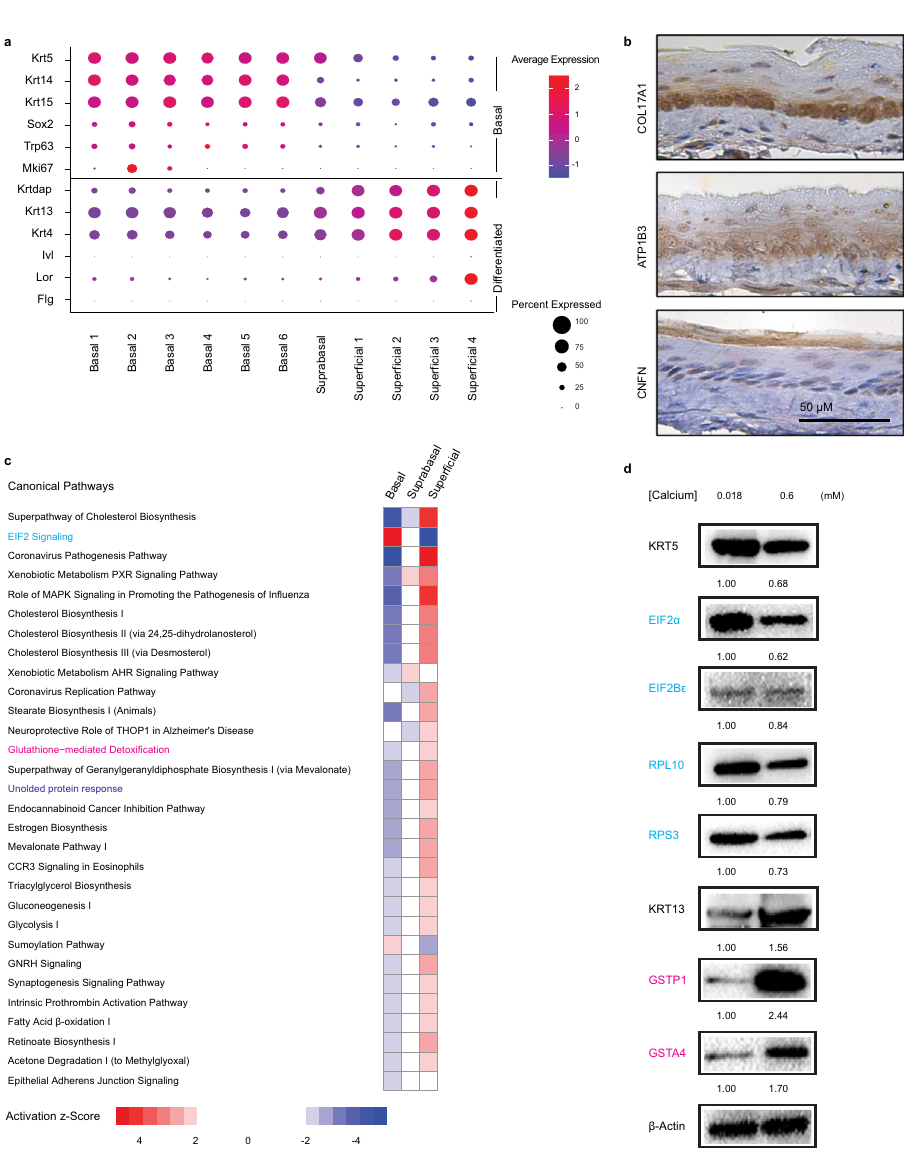
Fig. 1 Identi fi cation of cell populations in murine esophageal epithelium. a Schematic overview of experimental design. b Expression z-scores for the top 5 upregulated genes in each cluster. Red indicates enrichment while blue indicates inhibition. c Seurat ’ s Uniform Manifold Approximation and Projection (UMAP) was used to identify distinct cell populations within the epithelial dataset. Eleven epithelial cell populations were identi fi ed. d Genes identi fi ed as primary contributors to UMAP based on their loadings are listed and their expression z-scores in cells across the epithelial dataset are shown. Red indicates enrichment while blue indicates inhibition. e , f Log1p normalized expression of the basal markers Krt14 and Krt5 ( e ) and super fi cial markers Fabp5, Krt13, Krt4, and Krtdap ( f ) across the epithelial dataset is shown. Purple indicates enrichment. g Representative image of RNA fl uorescence in situ hybridization to visualize Krt5 and Krtdap in murine esophageal epithelium in situ ( n = 6 animals). Scale bar, 50 μ m.